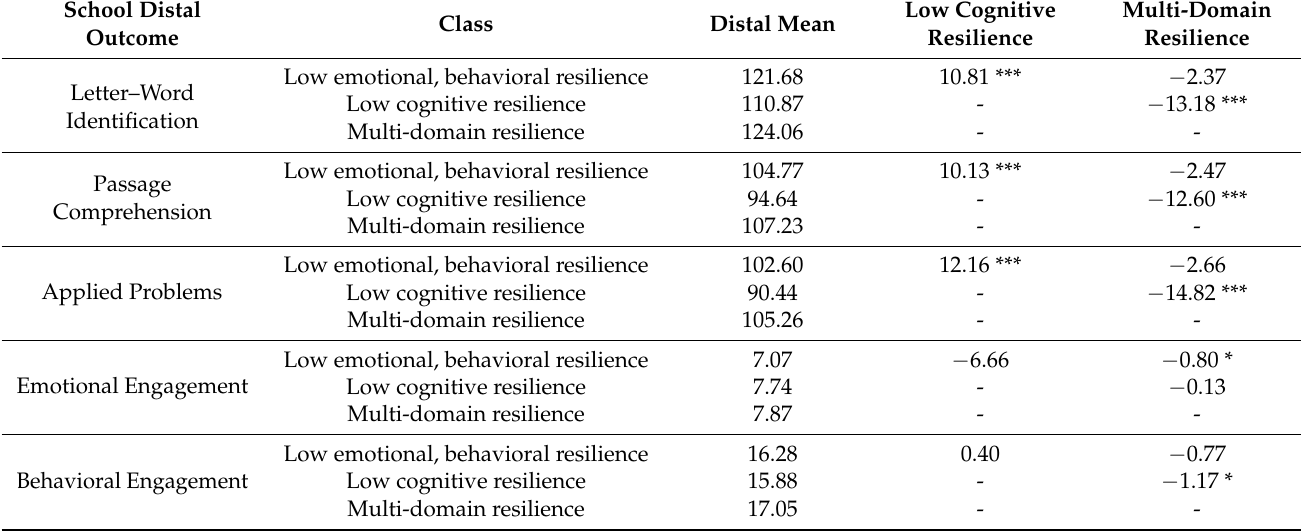
Table 2. Distal Mean Differences between Four Latent